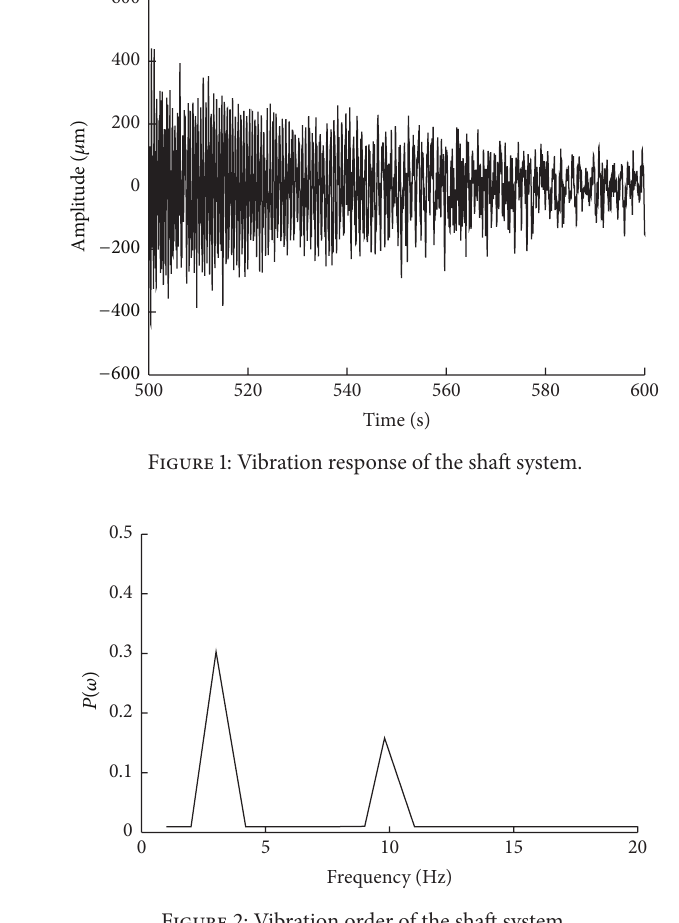
Figure 2: Vibration order of the shaft